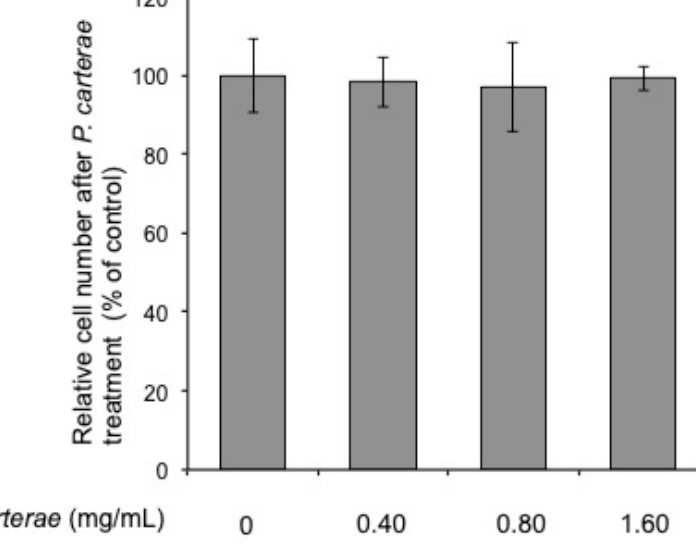
Figure 3. Effect of P. carterae extract on cell proliferation. B16F1 melanoma cells were cultured in the presence of P. carterae extract for 4 days. After treatment, the crystal violet assay was performed as described in Materials and Methods.